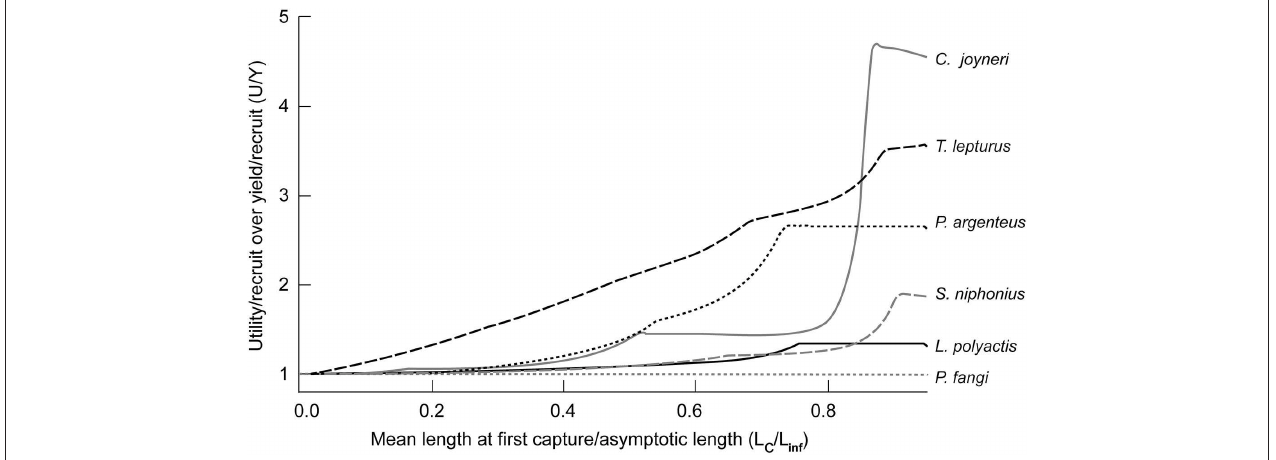
FIGURE 4 | Ratio of utility-per-recruit ( U/R ) to yield-per-recruit ( Y/R ) for different L c /L inf for 6 of the species caught in China’s coastal seas. Note that this ratio is near 1 when L c /L inf is